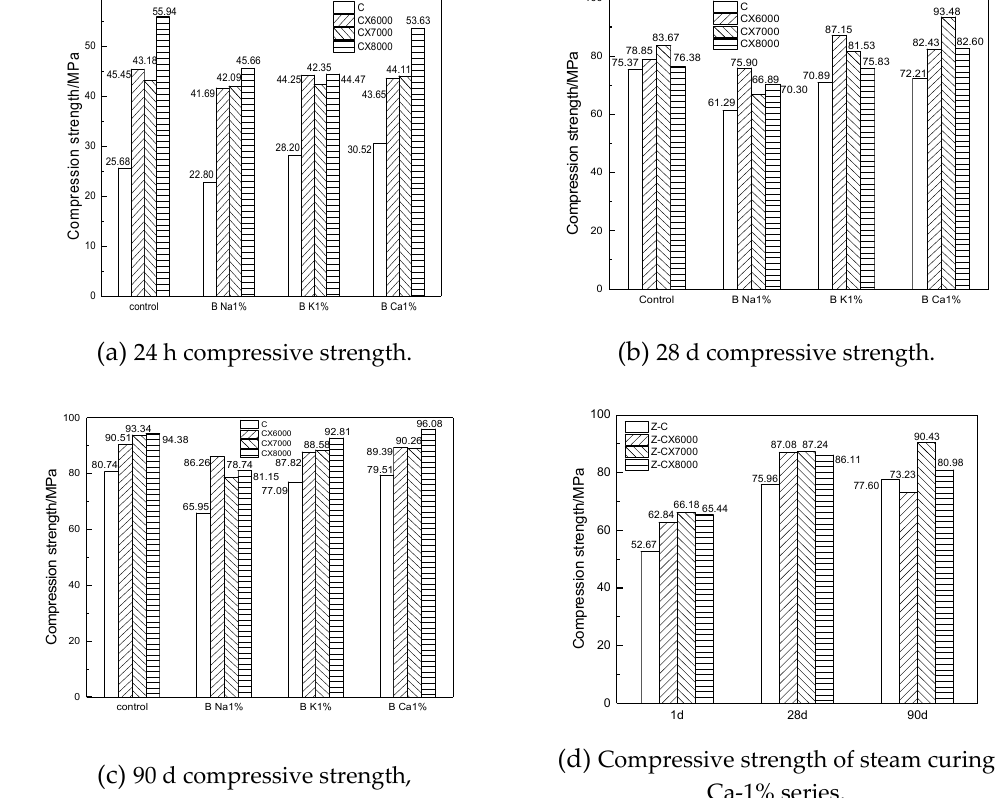
Figure 2. Ultrafine cement mortar compression strength with admixture/temperature at different ages.